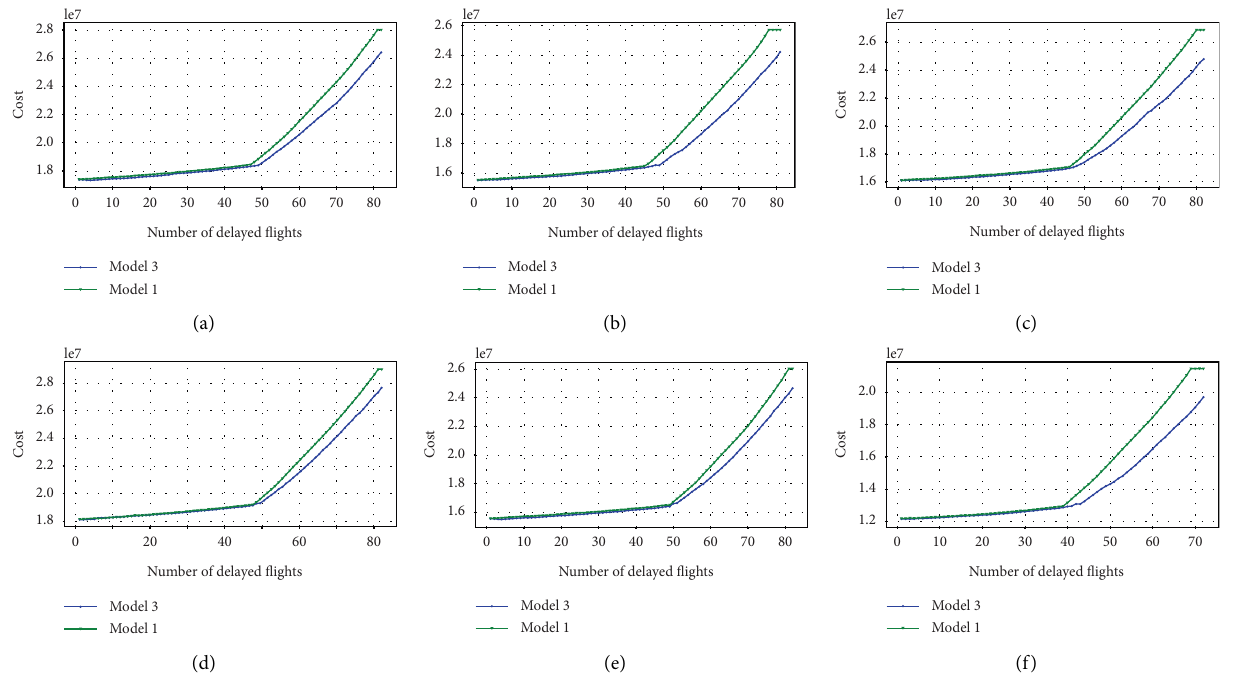
Figure 4: Delay costs under diferent models. (a) Monday. (b) Tuesday. (c) Tursday. (d) Friday. (e) Saturday. (f) Sunday.